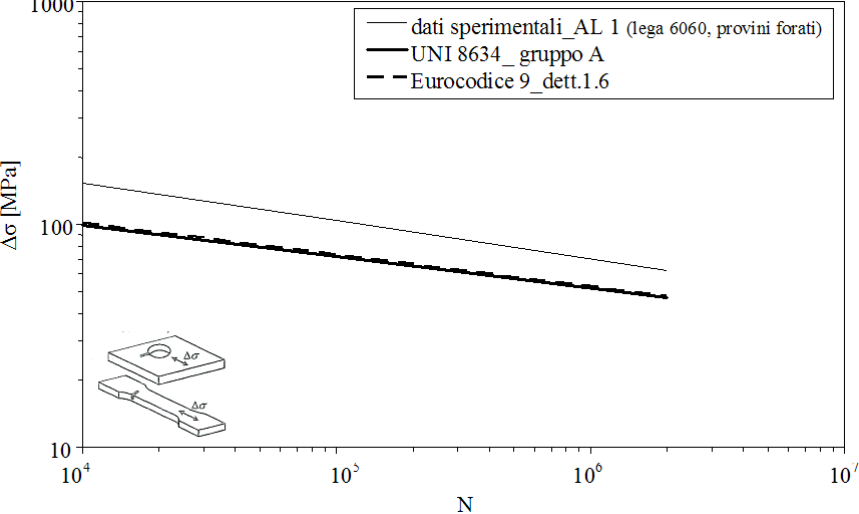
Figura 5: Confronto tra curve di resistenza a fatica per materiale base in lega 6060 (provini